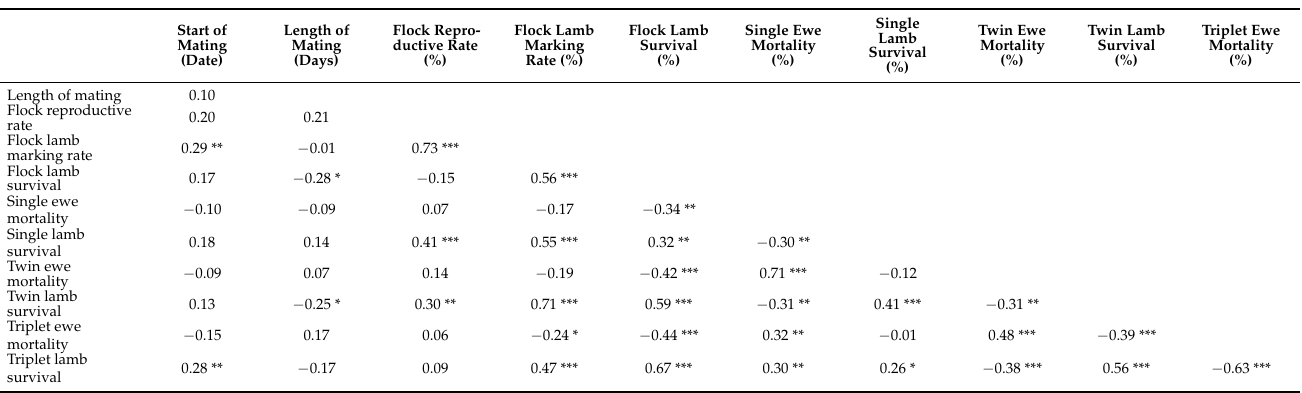
Table 4. Correlations between start date and length of the mating period, overall flock reproductive rate, marking rate and lamb survival, mortality of single-, twin- and triplet-bearing ewes and survival of their lambs to marking. The data were derived from 105 flocks of Merino and non- Merino ewes from 64 survey participants, where triplet-bearing ewes were managed separately from twin-bearing ewes.